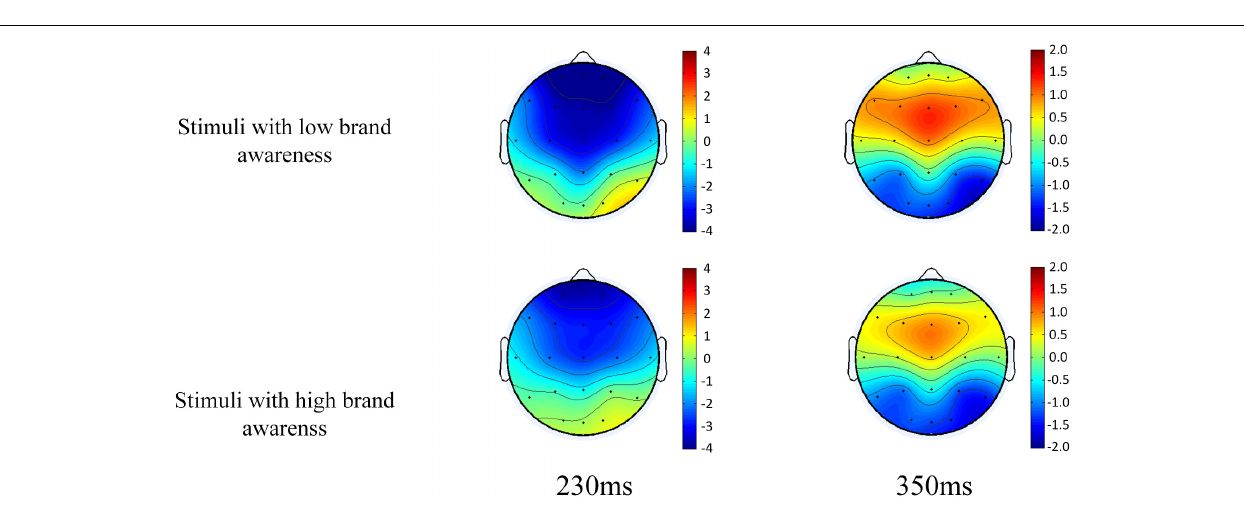
FIGURE 3 | Topographic maps of the voltage field topography. Topographic maps of the voltage field topography at the peak of the N2 and P3 evoked by stimuli with low and high brand awareness. Red and yellow are positive, blue and black are negative, scaled from − 4 to 4 mV (N2) or − 2 to 2 mV (P3).